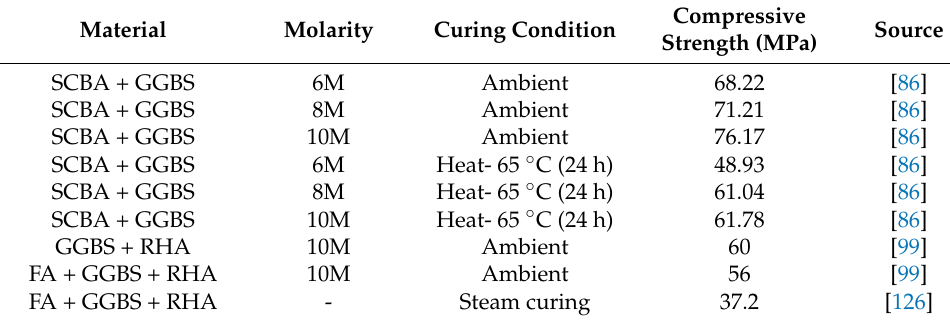
Table 4. Impact of curing method on alkali-activated